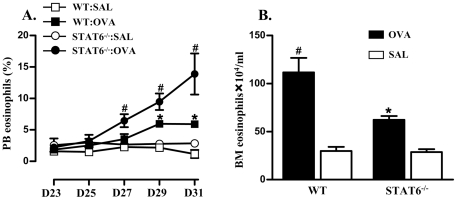
Eosinophil levels in peripheral blood and bone marrow.OVA/OVA treatment of WT and STAT6-deficient mice significantly increased (A) levels of eosinophils as percentages of leukocytes in peripheral blood and (B) numbers of eosinophils in bone marrow compared to SAL/OVA treated controls. OVA/OVA treated STAT6-deficient mice had a greater percentage of eosinophils in peripheral blood but significantly fewer eosinophils in the bone marrow than OVA/OVA treated WT controls. #P<0.05 compared to other groups. *P<0.05 compared to SAL/OVA treated controls.